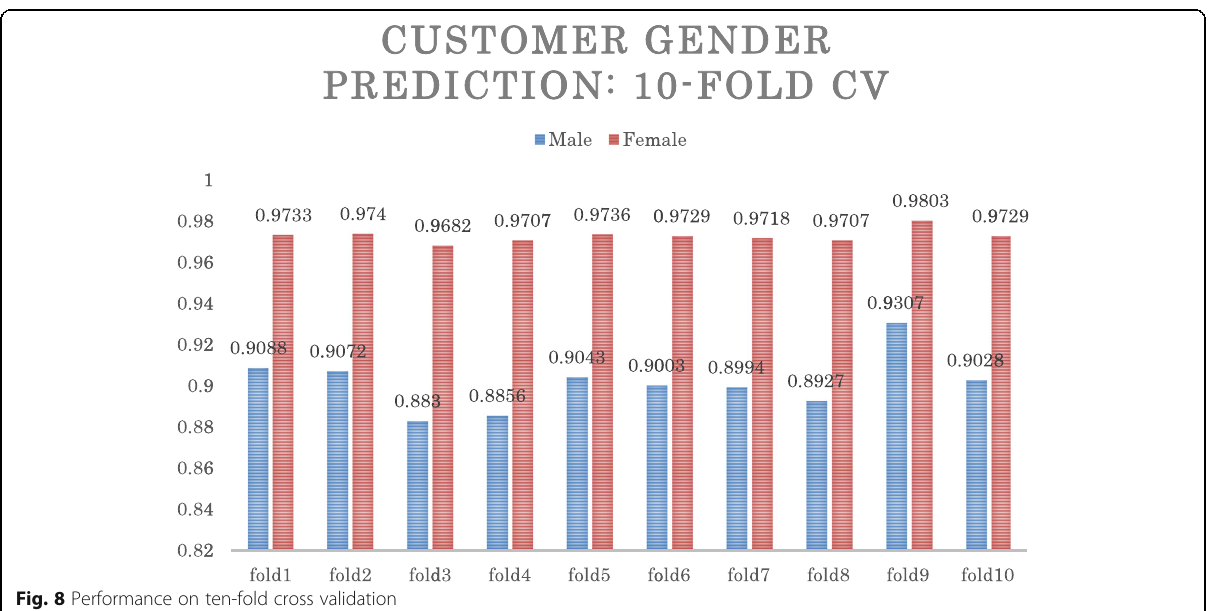
Fig. 8 Performance on ten-fold cross